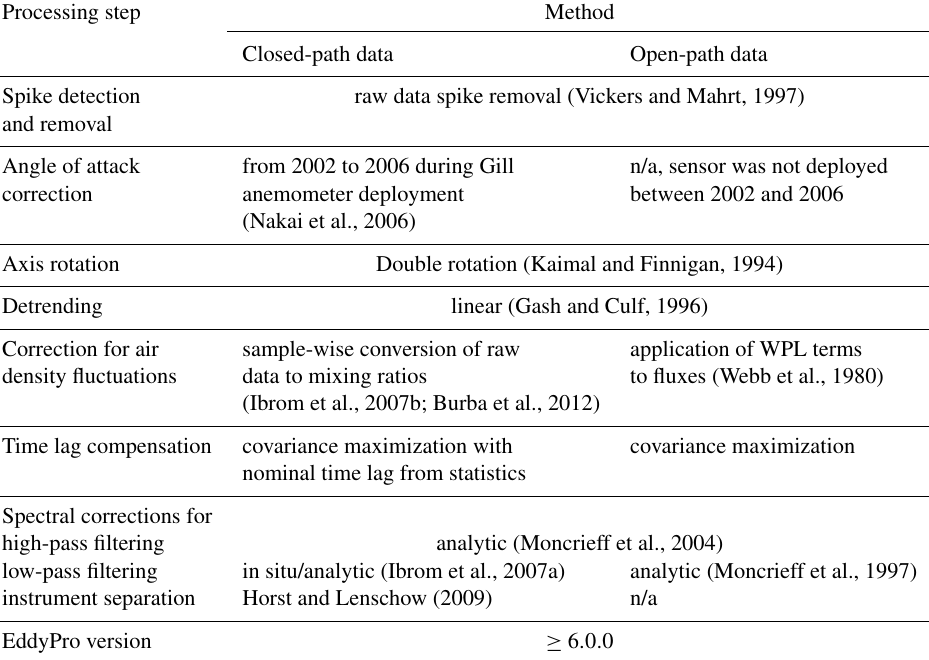
Table 2. Eddy covariance flux processing steps. Partly differing processing was applied to raw data from closed- and open-path analyzers. OP and CP fluxes were computed consistently for the whole period from 2002 to 2017. Setup-dependent statistics (for time lags and in situ spectral correction methods) were evaluated annually or if tower position, CP pump speed or any other analyzer metadata changed.